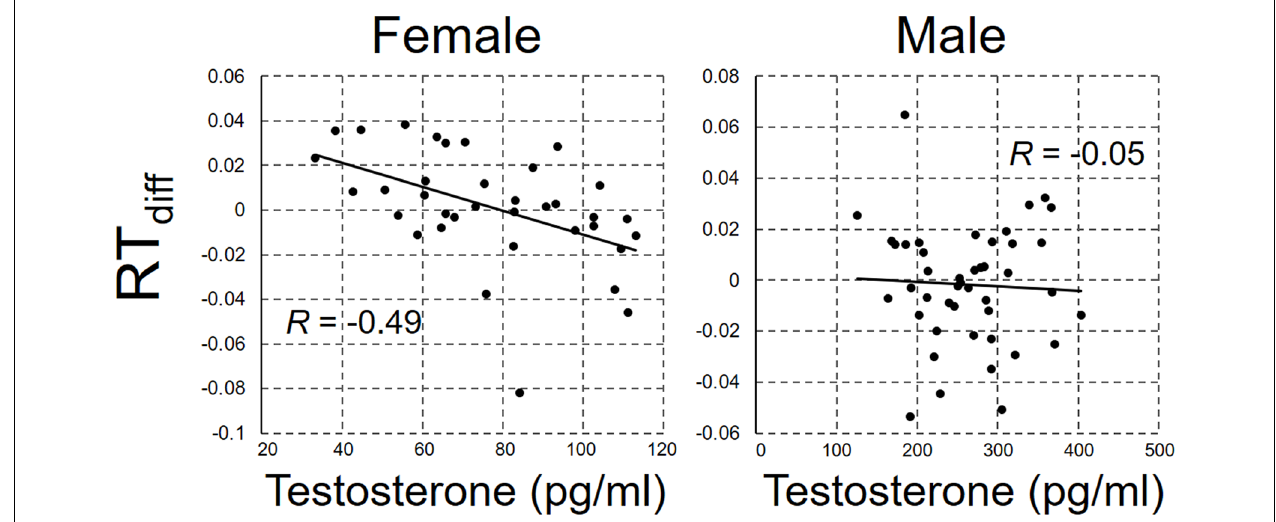
FIGURE 2 | The scatterplot between RT diff and salivary testosterone concentration for female and male participant.